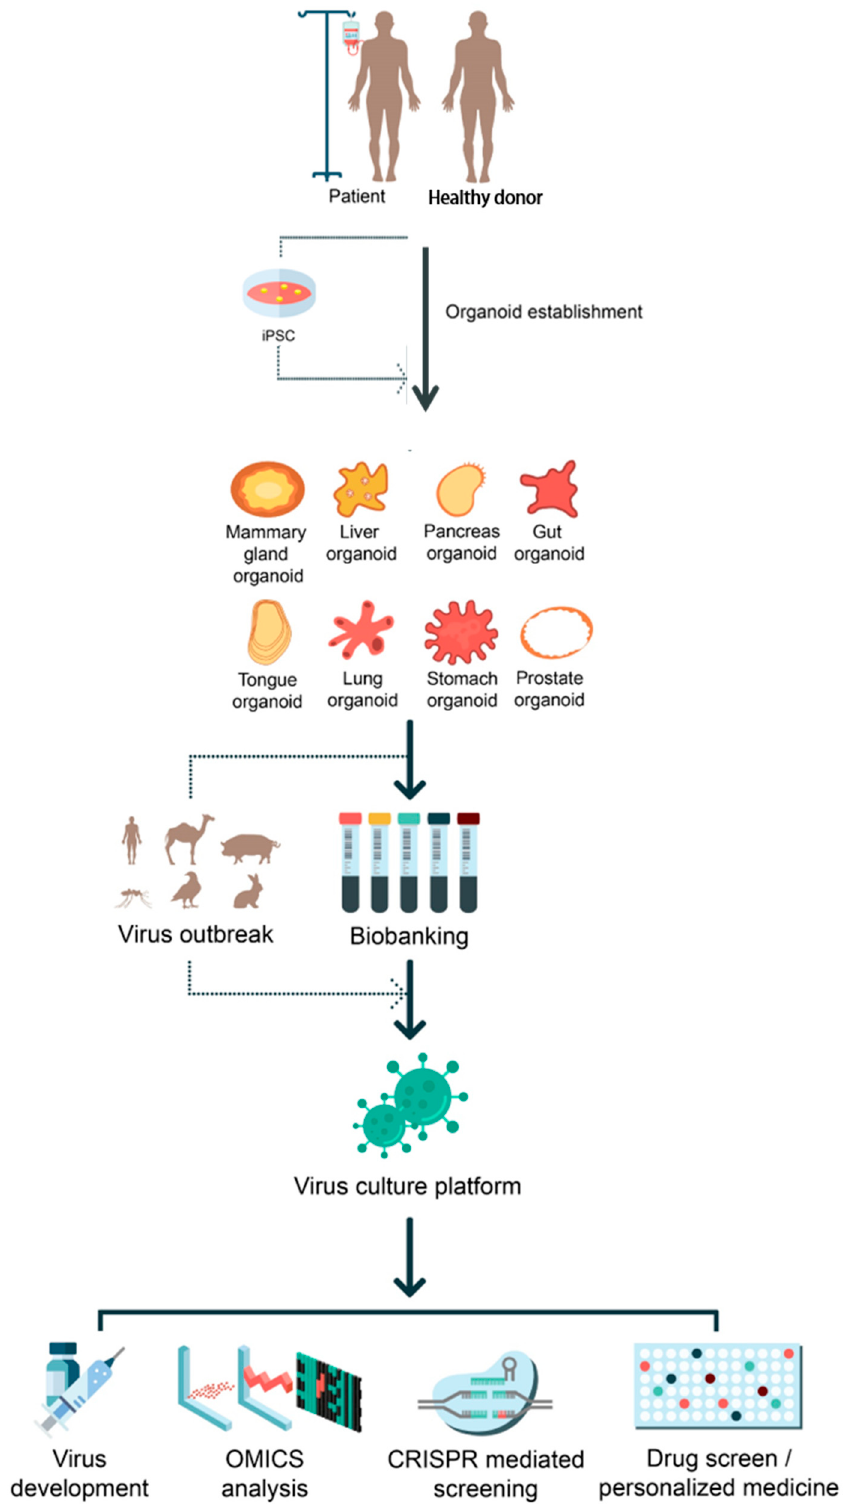
Figure 1. Applications of organoids on virus-mediated diseases. Potential applications of iPSC-derived and adult stem-cell-derived organoid systems for the viral pathogen outbreak are illustrated. Established organoids from different organs can serve as a proper virus culture platform for many purposes such as vaccine generation, OMICS analysis, CRISPR/Cas9-mediated screening, and drug screening for personalized medicine.